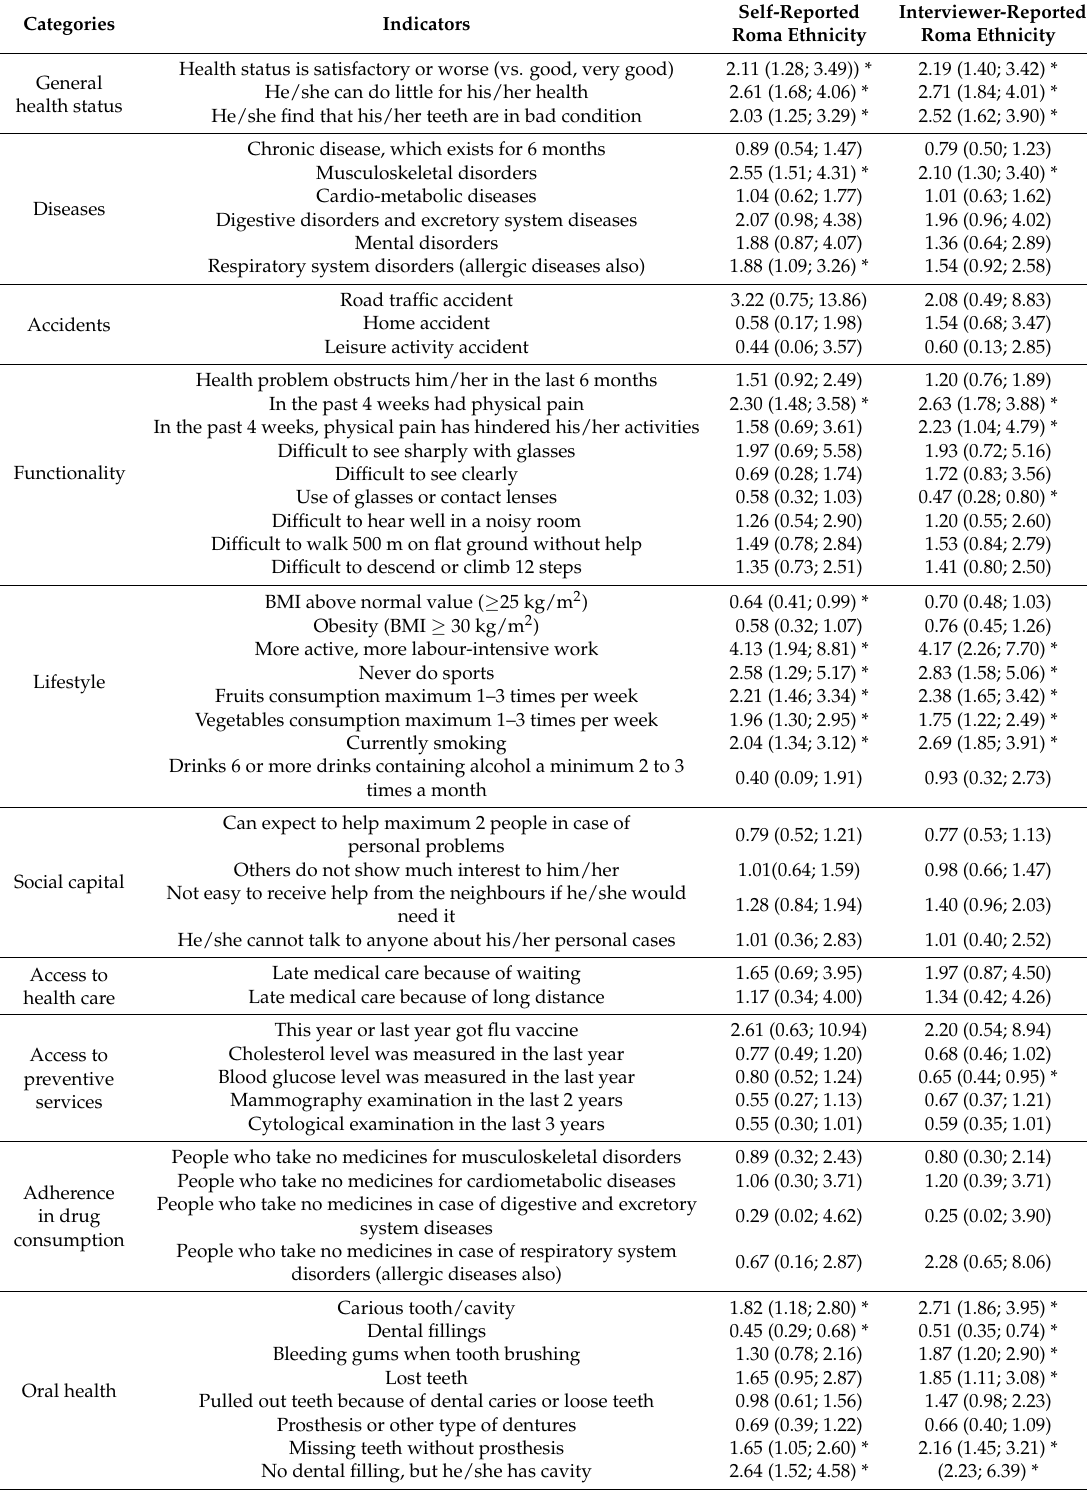
Table 4. Health determining role of Roma ethnicity according self-reported and interviewer-reported Roma ethnicity assessment (odds ratios with 95% confidence intervals in parentheses from multivariate logistic regression models controlled for age, sex, education and